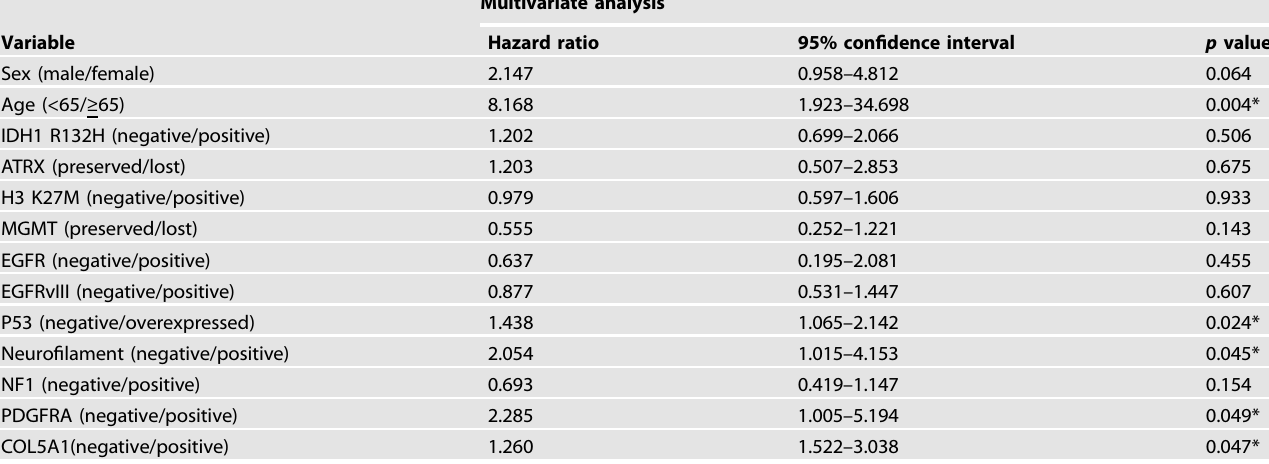
Table 2. Multivariate analysis of COL5A1 expression and clinical parameters in